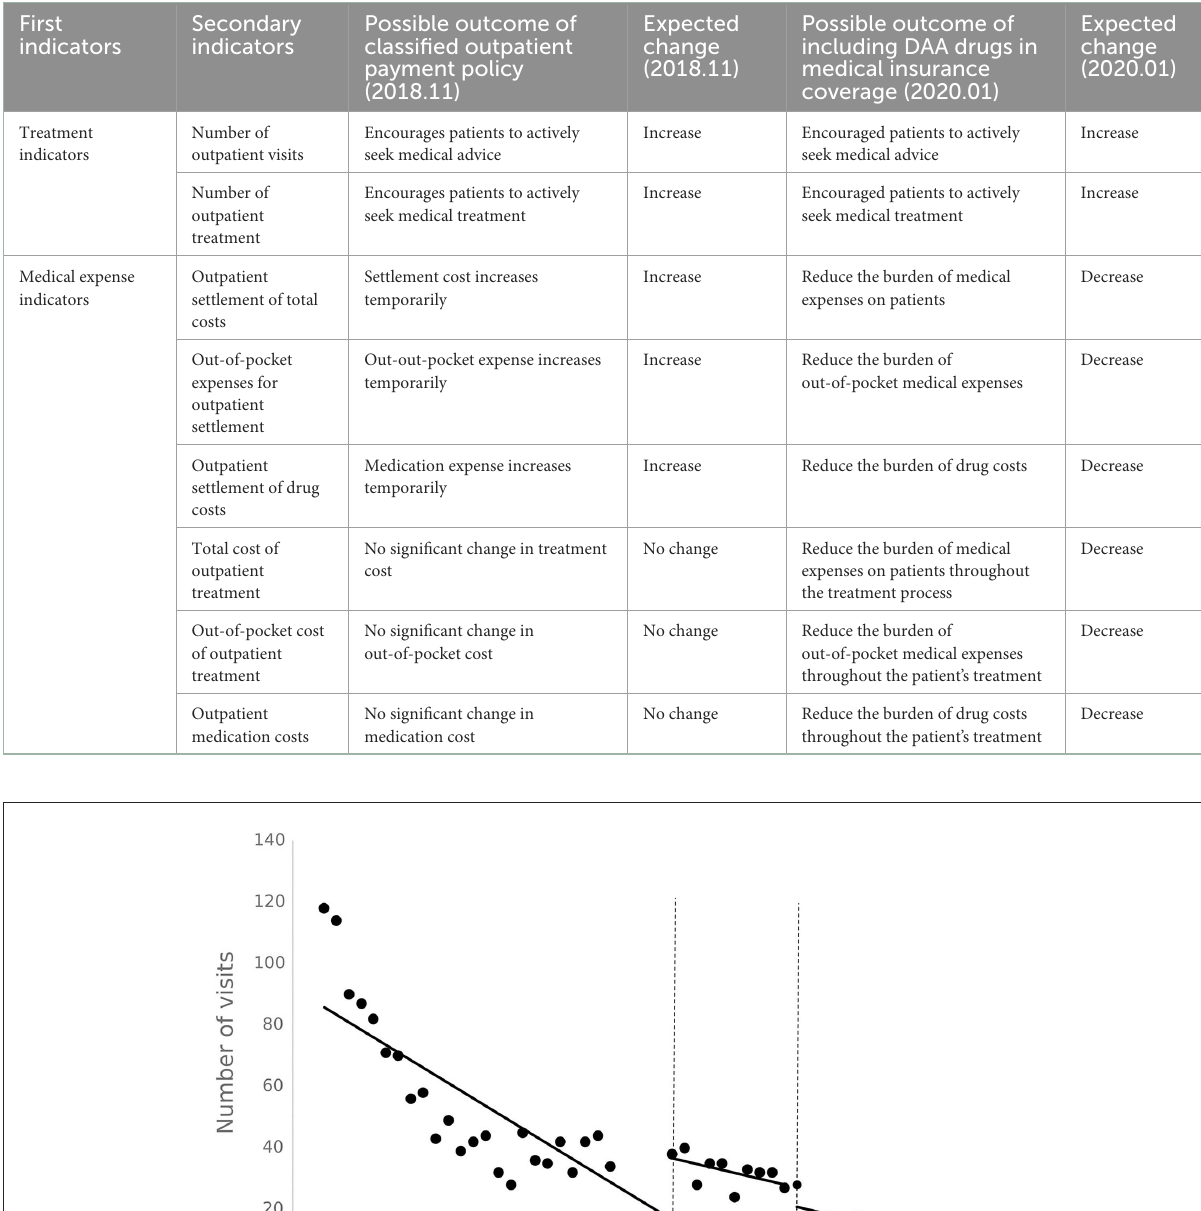
TABLE 1 Research indicators and hypothesis.